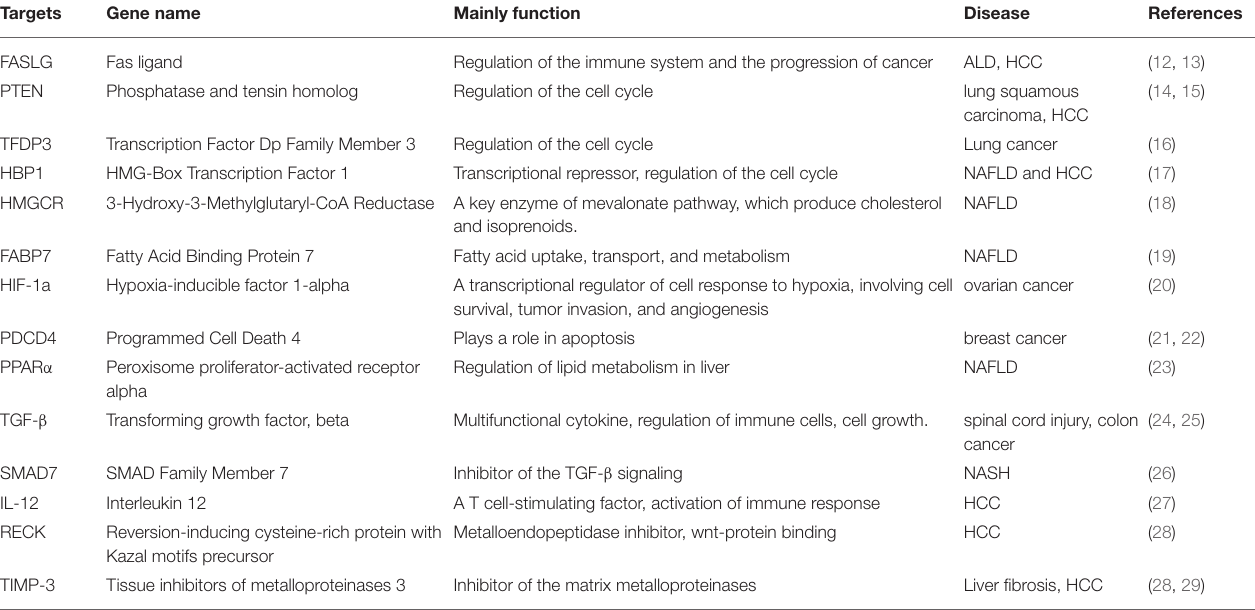
TABLE 1 | Reported gene targets known to be regulated by